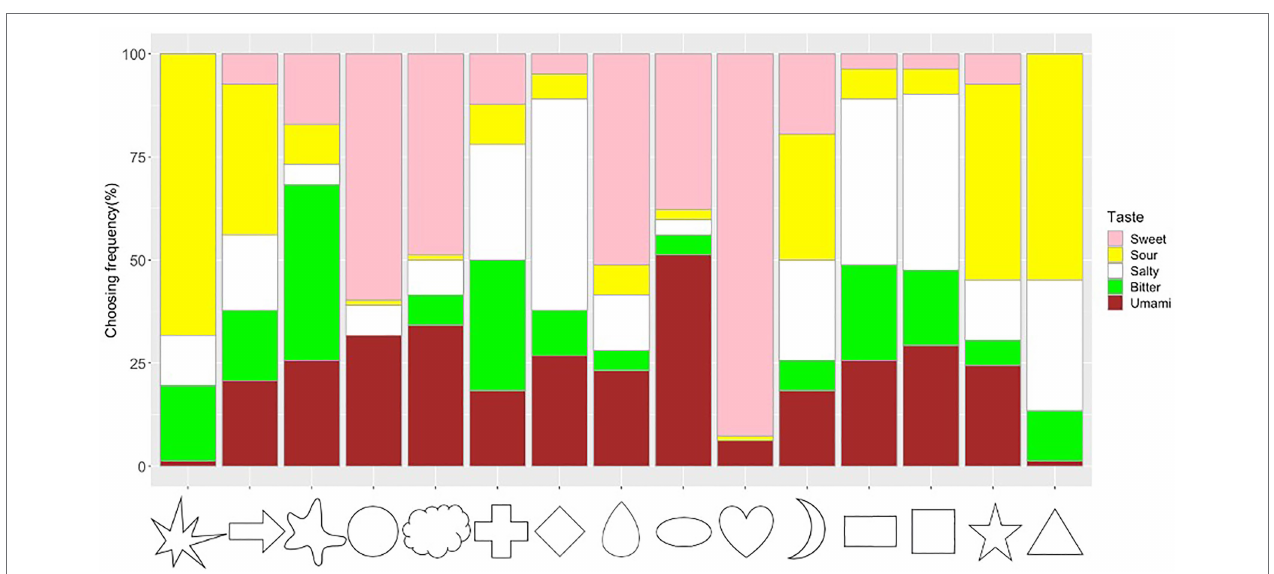
FIGURE 5 | Frequency of taste choices for each shape. Note that the frequency of the sweet, sour, salty, bitter, and umami taste terms for the shape stimuli are represented by the fill-in colors pink, yellow, white, green, and brown, respectively.